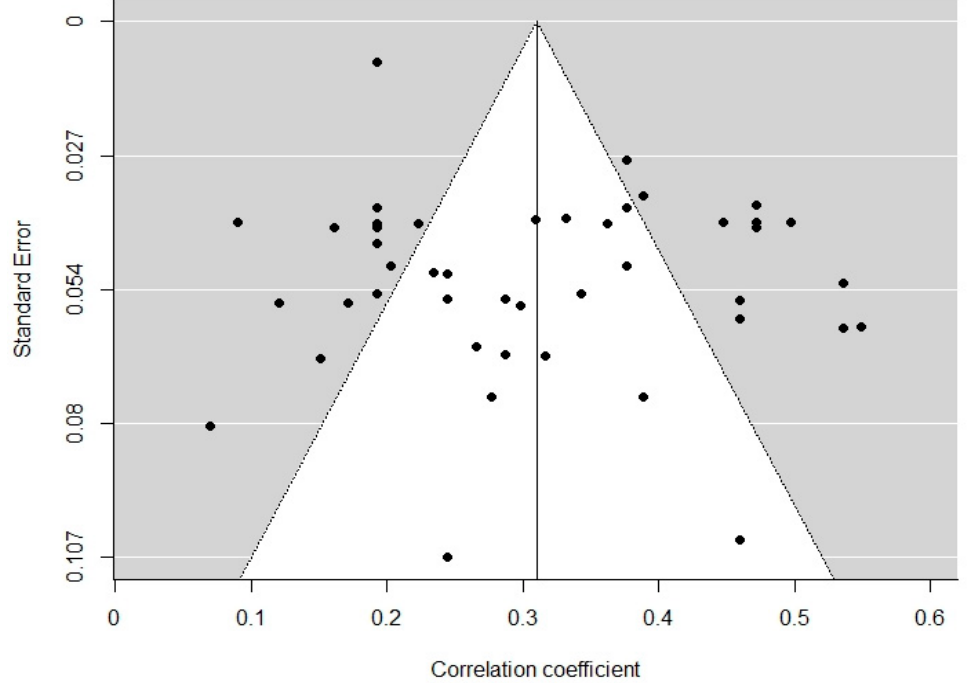
Figure 2. Funnel plot for illustrating publication bias.